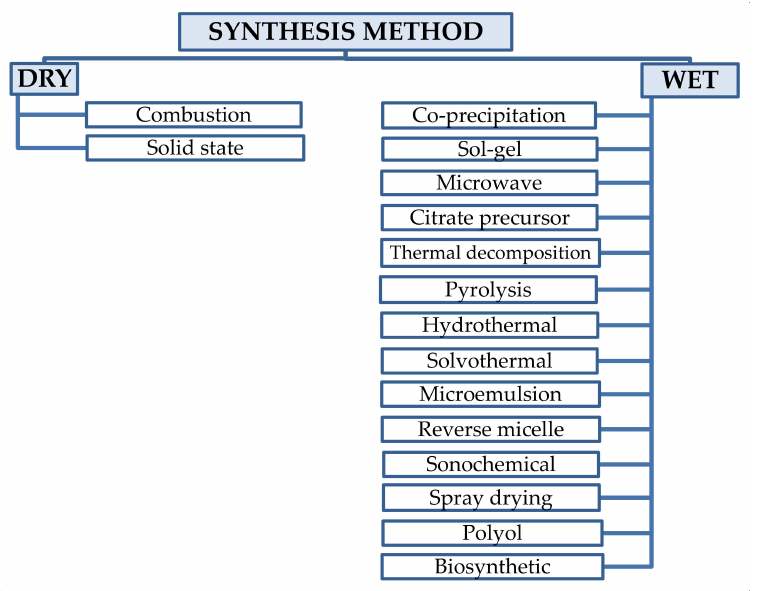
Figure 2. Classification of nanoferrite synthesis